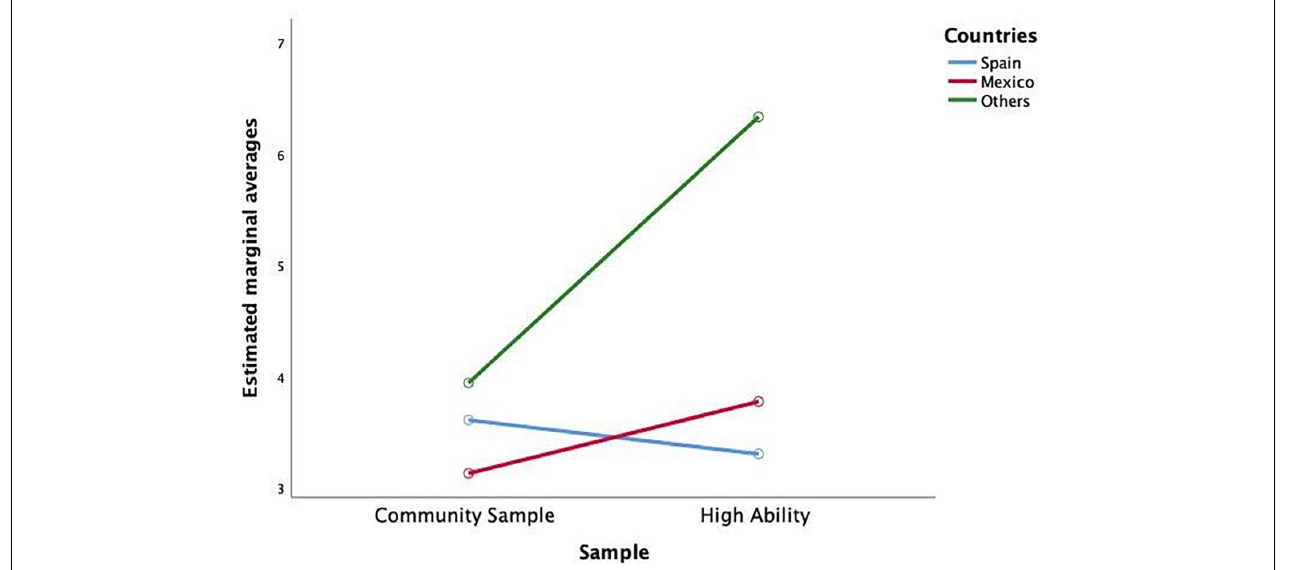
FIGURE 1 | Interaction of the variables country and sample in time devoted to